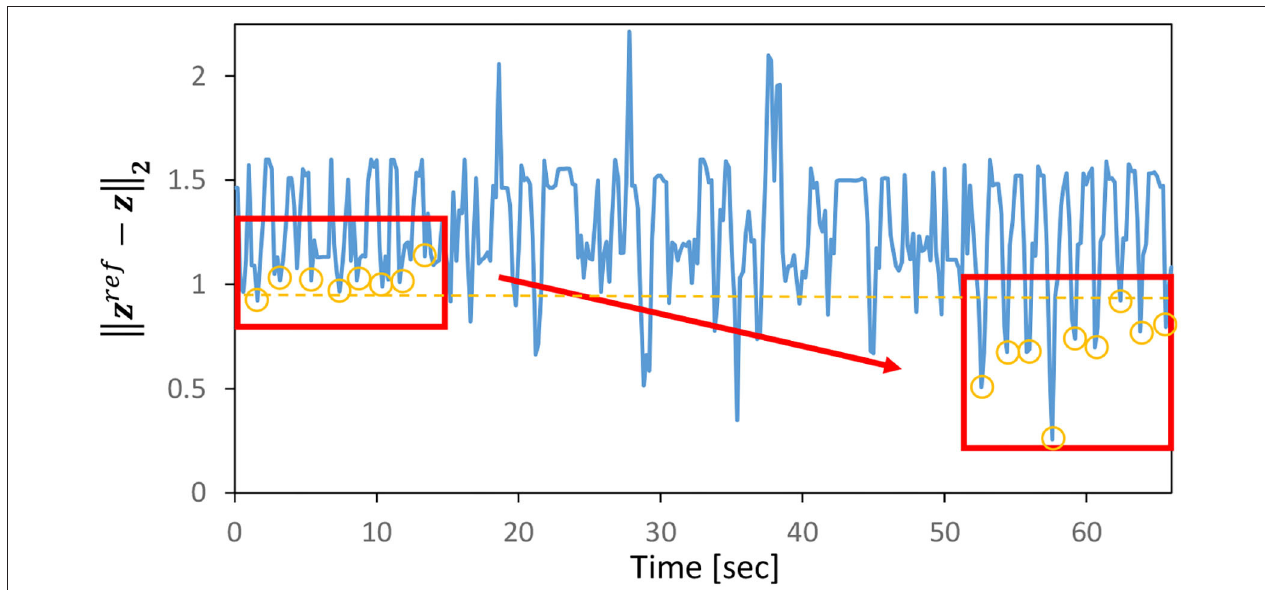
FIGURE 7 | Simulation experiment: the transition of || z ref − z || 2 for the integrated experiment of online estimation and dynamic cloth manipulation.